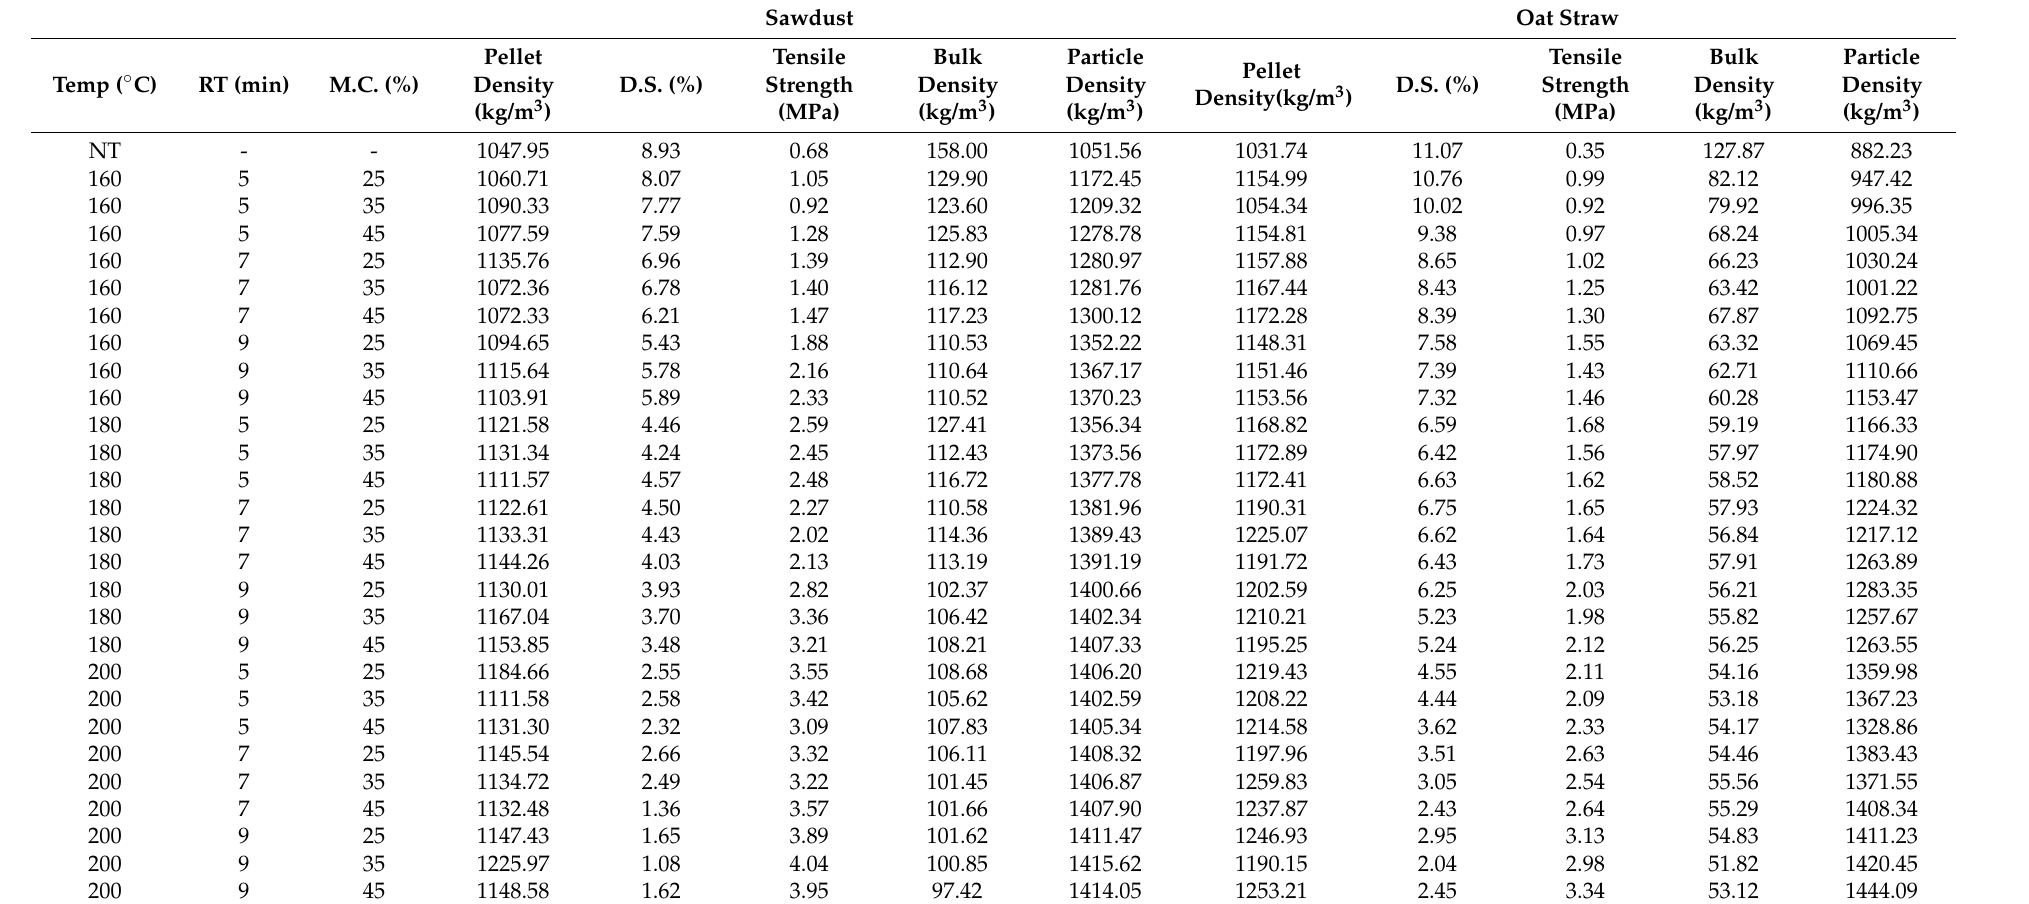
Table 1. Properties of pellets from non-treated and steam-exploded